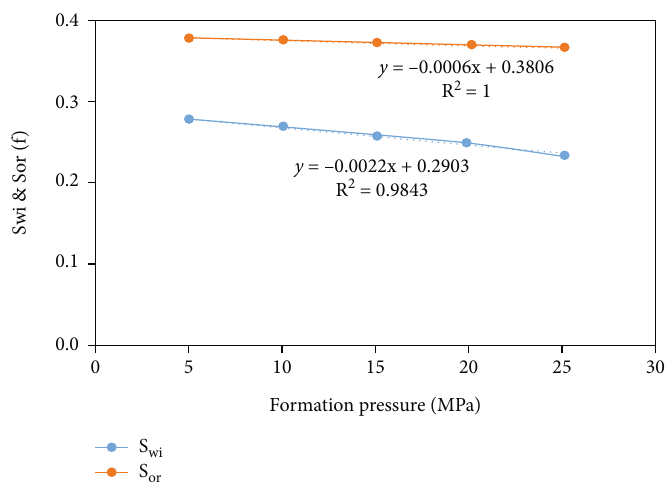
S wi , or , and formation pressure.